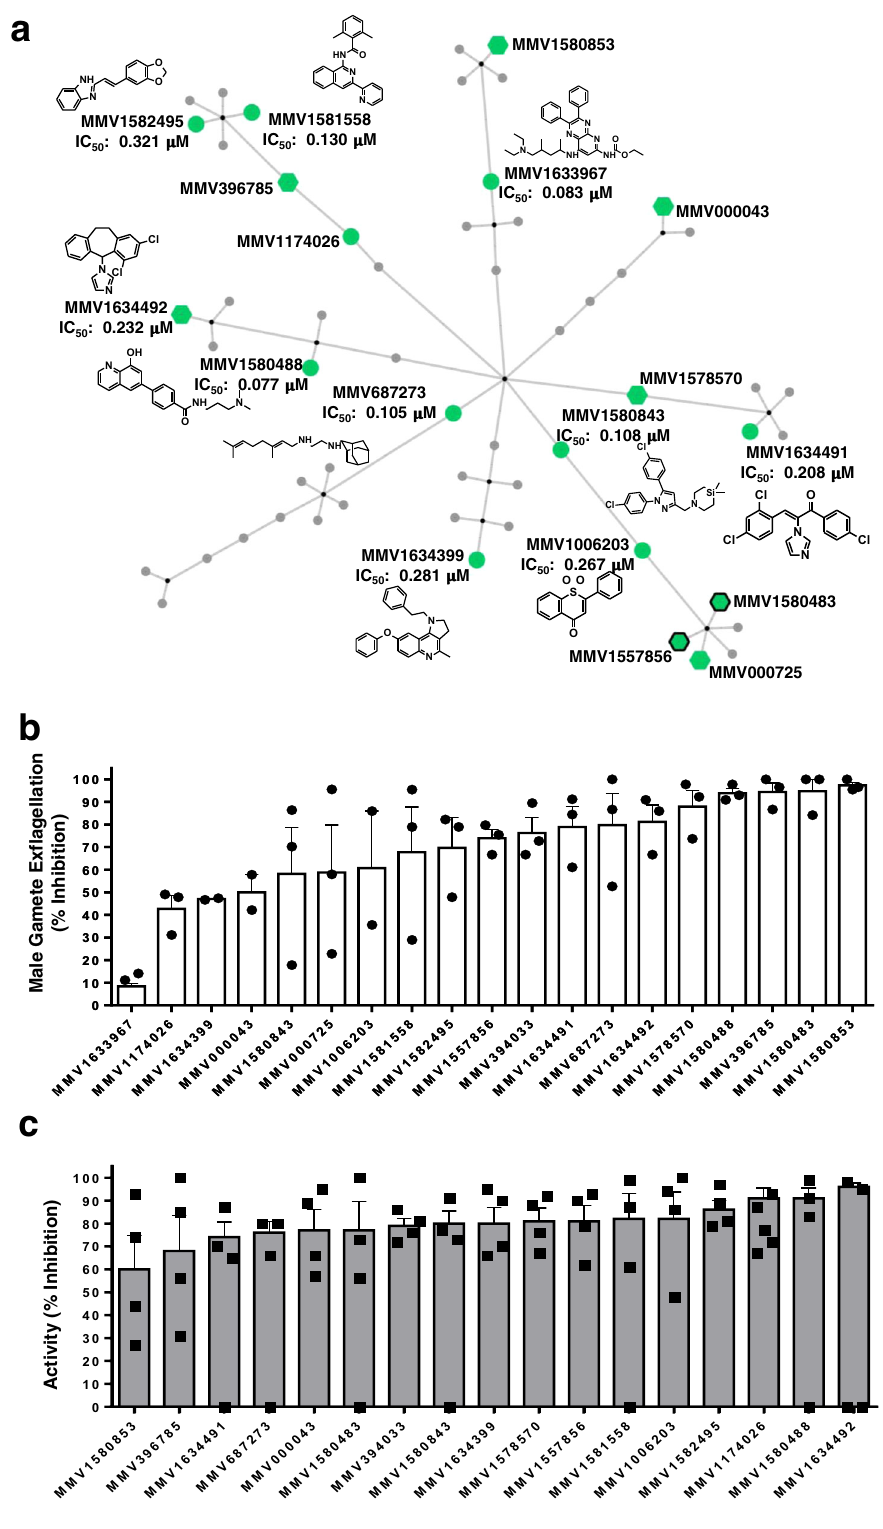
ML324 treatment signi fi cantly increased H3K9me3 levels (a repressive heterochromatin mark in P. falciparum gameto- cytes) 30 in late-stage gametocytes, while not affecting acetylation (Fig. 6b, p = 0.028, t test, n = 3). This translated to differential expression of 13% of the genome (Fig. 6c, p < 0.01, >0.5 log 2 fold change (FC) in either direction, Supplementary Data 4), similar